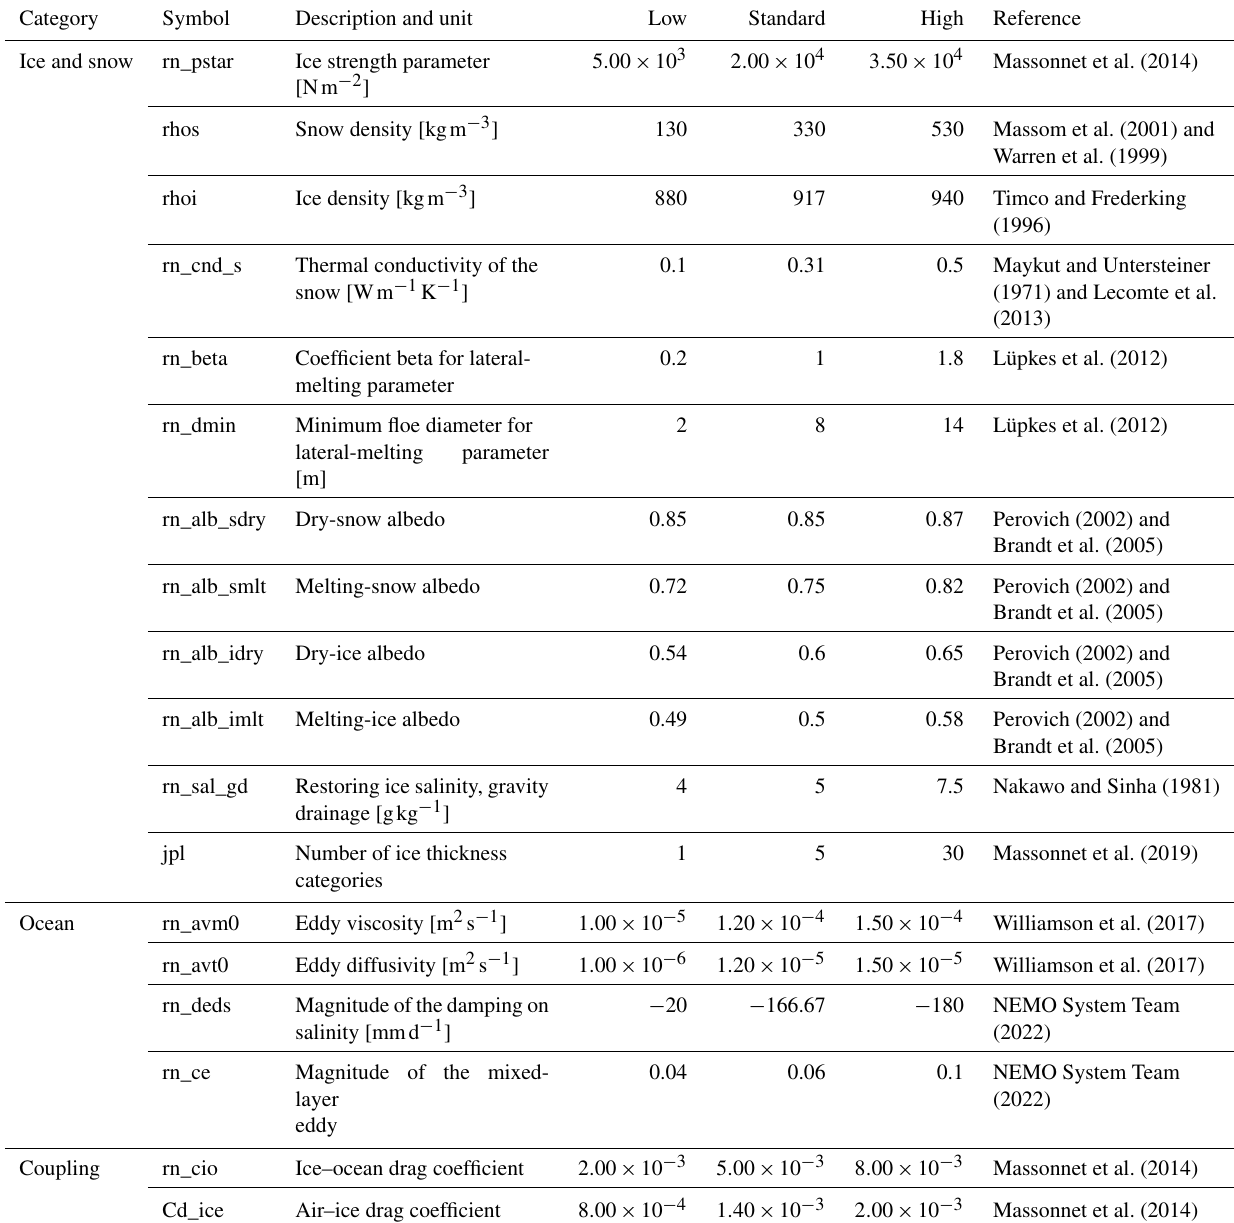
Table 1. The 18 parameters investigated, including their realistic ranges taken from the listed references. Category